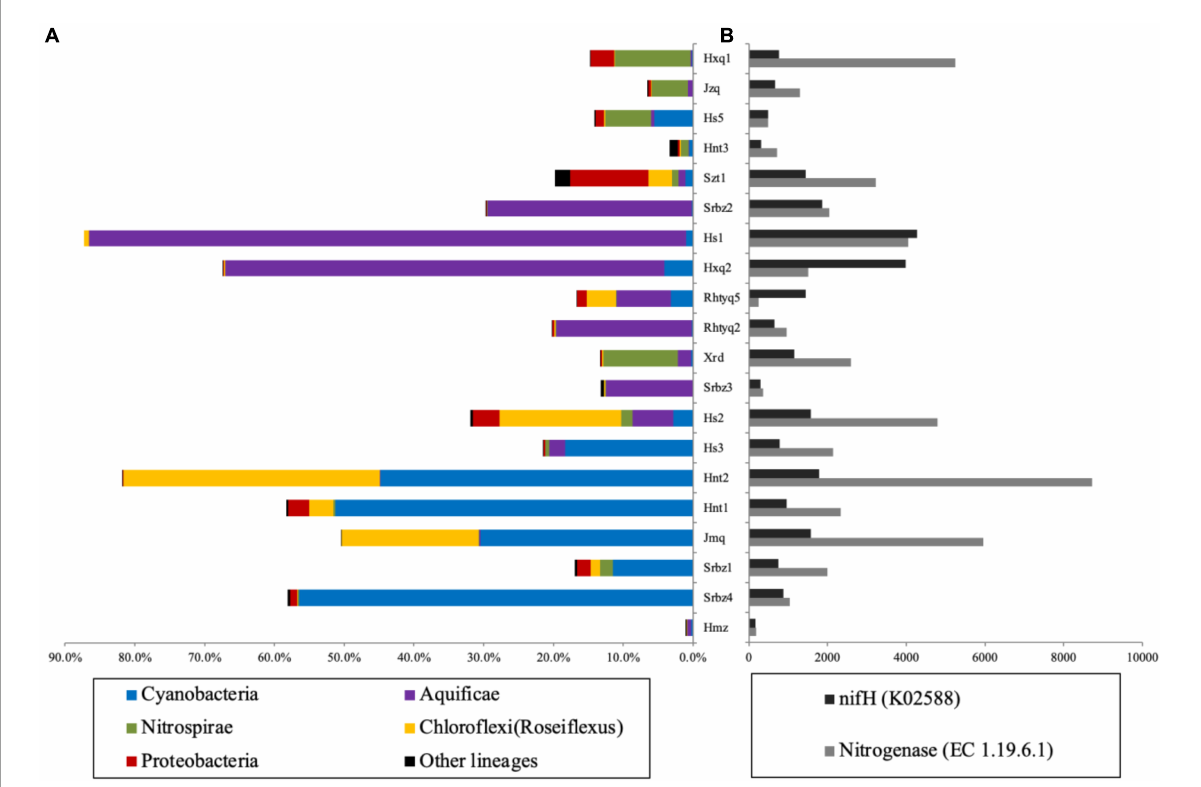
FIGURE1 The predictive analysis of nitrogen fixing functions at the level of phylum, enzyme and gene based on the 16S rRNA gene data. Panel (A) showed the compositions of predicted potential diazotrophic taxa; Panel (B) showed the abundance of predicted nitrogenase and nifH gene. Note: Piphillin and PICRUSt were applied for the predictions of nitrogenase and nifH gene,